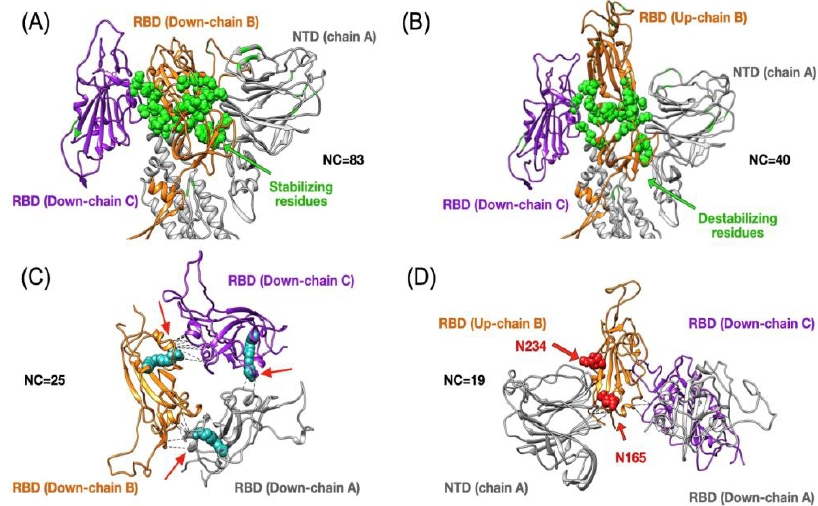
Figure 4. Top panels show changes in terms of stability between the closed (3down) and open (1up2down) states. Panel ( A ) shows the case of the RBD in chain B stabilized by neighboring protein domains such as the RBD and NTD from chain C and A, respectively. The stabilizing 25 residues are highlighted in green and they establish several high-frequency native contacts (NC) equal to 83. Panel ( B ) shows the same set of residues from panel ( A ) that are destabilized in the open state forming 40 contacts. Panel ( C ) shows the stabilization due to 25 contacts between all RBDs in the closed state. The structure of the FFA (in cyan) has been superimposed onto our results as it was shown to lock the closed state by forming contacts between two adjacent RBDs. Panel ( D ) depicts the RBD in up conformation that has been stabilized by 19 contacts formed between the NTD and two other RBDs. The positions of two N-glycans that assist structurally by making extensive interaction with the RBD in the up conformation have been superimposed onto our structure. We highlight the residue contacts that are responsible for stabilization by dashed black lines.